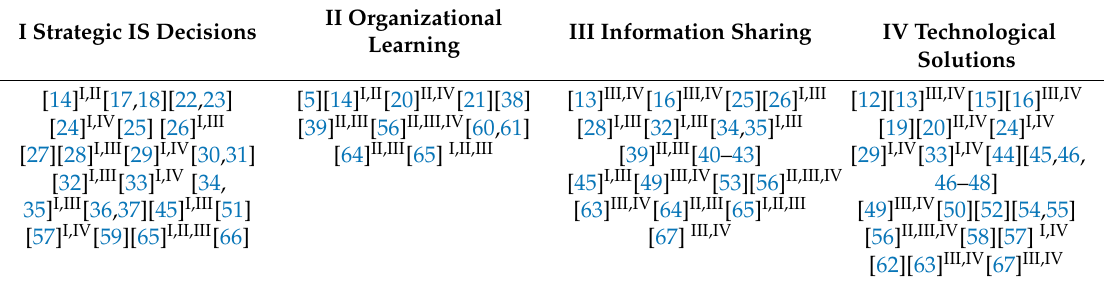
Table 5. Overview of the value-creating factors and associated